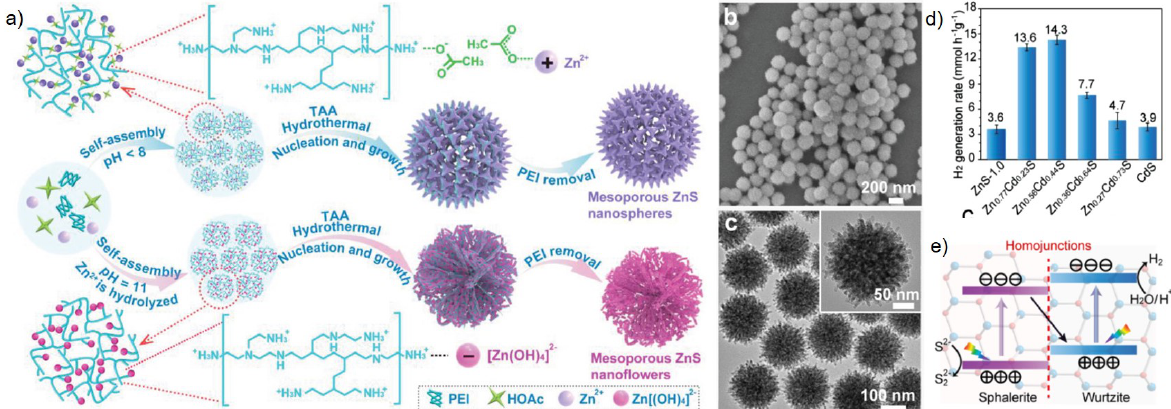
Figure 16. ( a ) Schematic illustration of the synthesis procedure of mesoporous ZnS nanostructures. ( b , c ) SEM and TEM images of mesoporous ZnS-1.0, respectively. ( d ) Photocatalytic HER of meso- porous Zn x Cd 1 − x S with different Cd content. ( e ) Schematic view of a photocatalytic charge transfer mechanism for mesoporous Zn 0.56 Cd 0.44 in H 2 evolution reaction. [149] Copyright 2021,